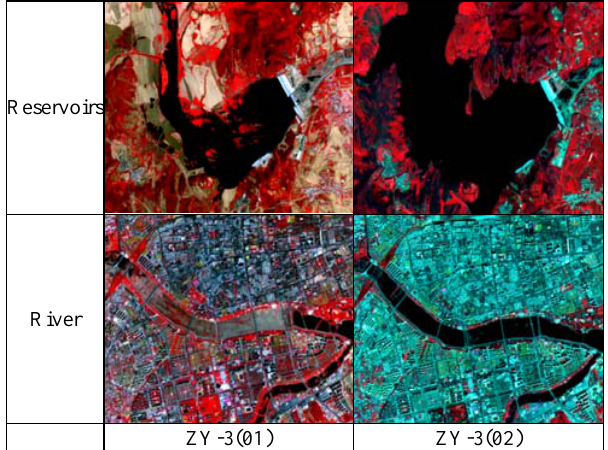
Figure 6. The reservoirs and river on ZY-3(01) and ZY-3(02)